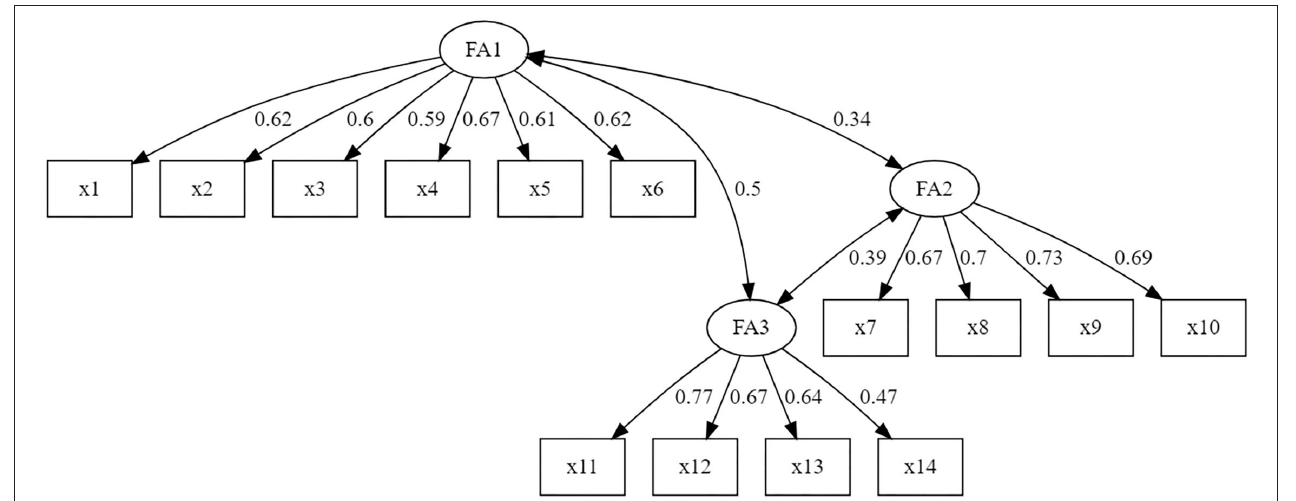
FIGURE 3 | Three-factor model with standardized estimates.